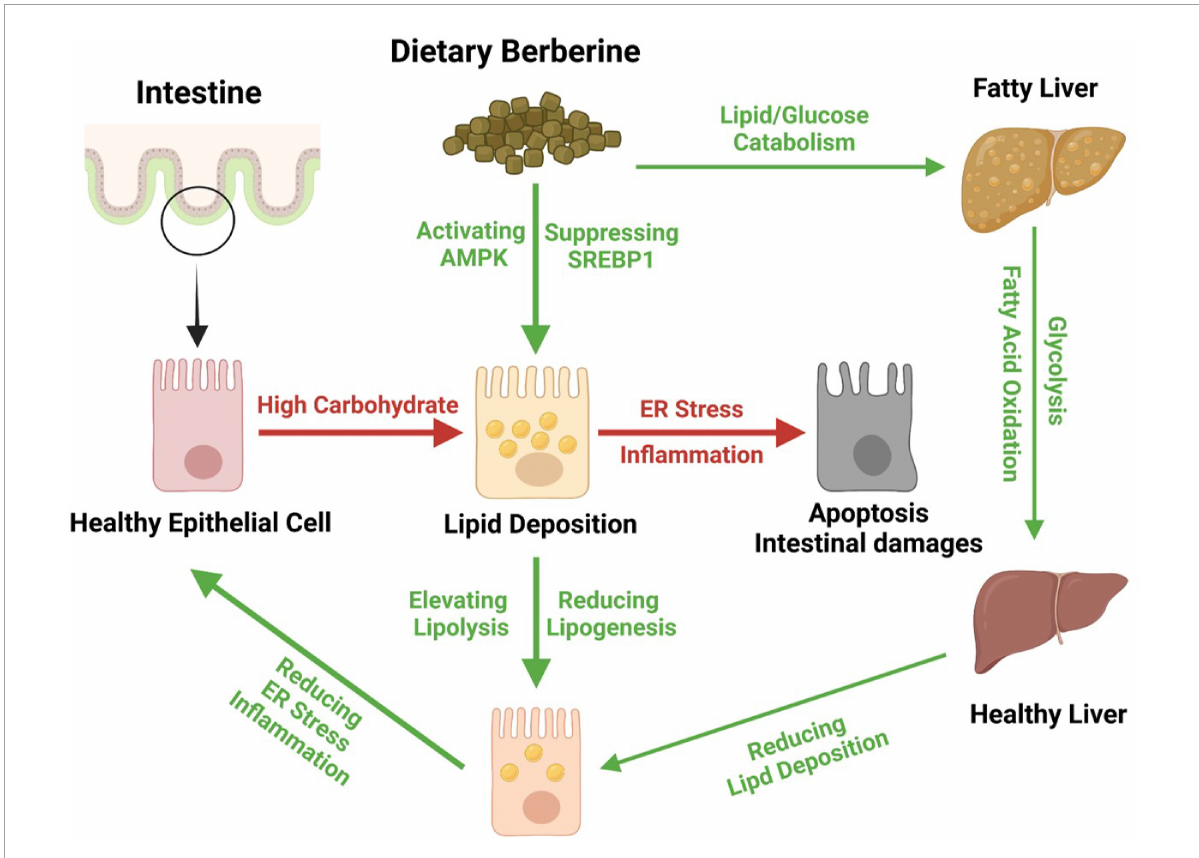
FIGURE7 Proposed working model depicting dietary berberine alleviates HCD-induced intestinal damages via improving lipid metabolism in largemouth